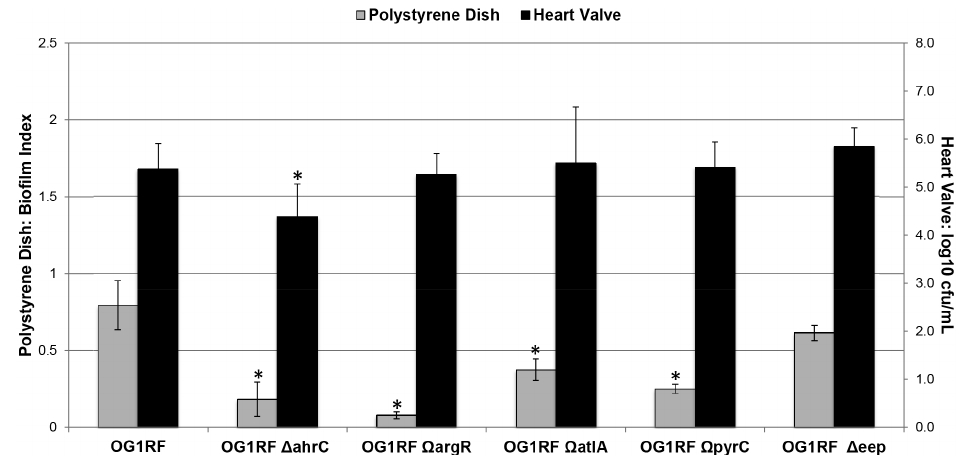
Figure 4. Comparison of Enterococcusfaecalis strains previously tested in an animal model in the polystyrene dish assay vs. the heart valve assay. Strains OG1RF V argR, OG1RF V atlA , and OG1RF V pyrC were previously shown to be attenuated in a polystyrene dish assay but not in an in vivo rabbit endocarditis model. OG1RF D eep has an altered biofilm phenotype resulting in no difference from the parent strain in the polystyrene dish assay but attenuation of endocarditis virulence in rabbits. These mutants, the wild type OG1RF, and OG1RF D ahrC were evaluated in the polystyrene dish assay using TSB without dextrose and the heart valve assay. Error bars represent standard deviation. *indicates p , 0.01 for less biofilm formation compared to OG1RF (for the same conditions). Note that in the heart valve assay the only strain with a significant reduction in